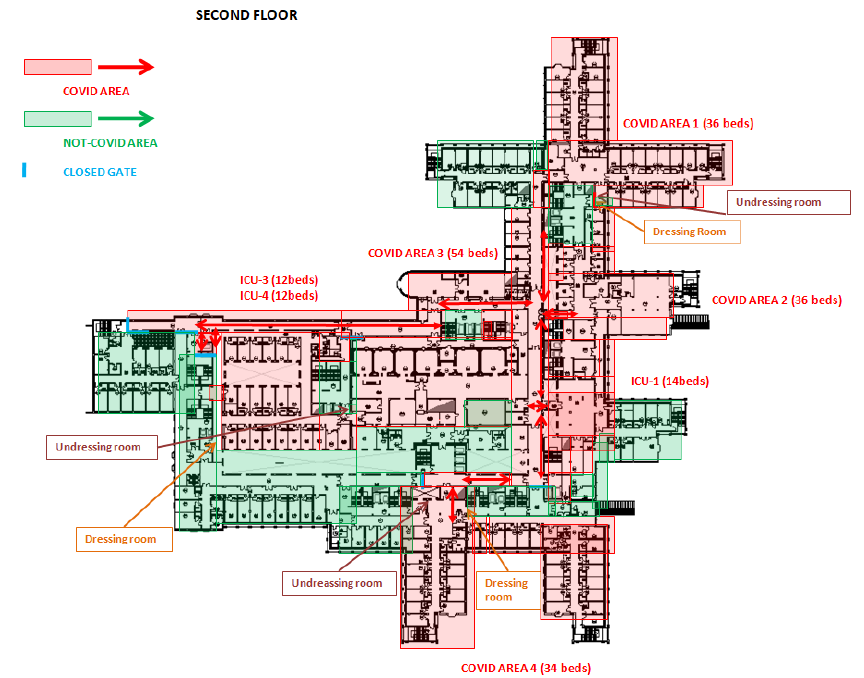
Figure 4. Planimetry of the second floor of Cisanello hospital sector, where the COVID areas (in red) were set up.